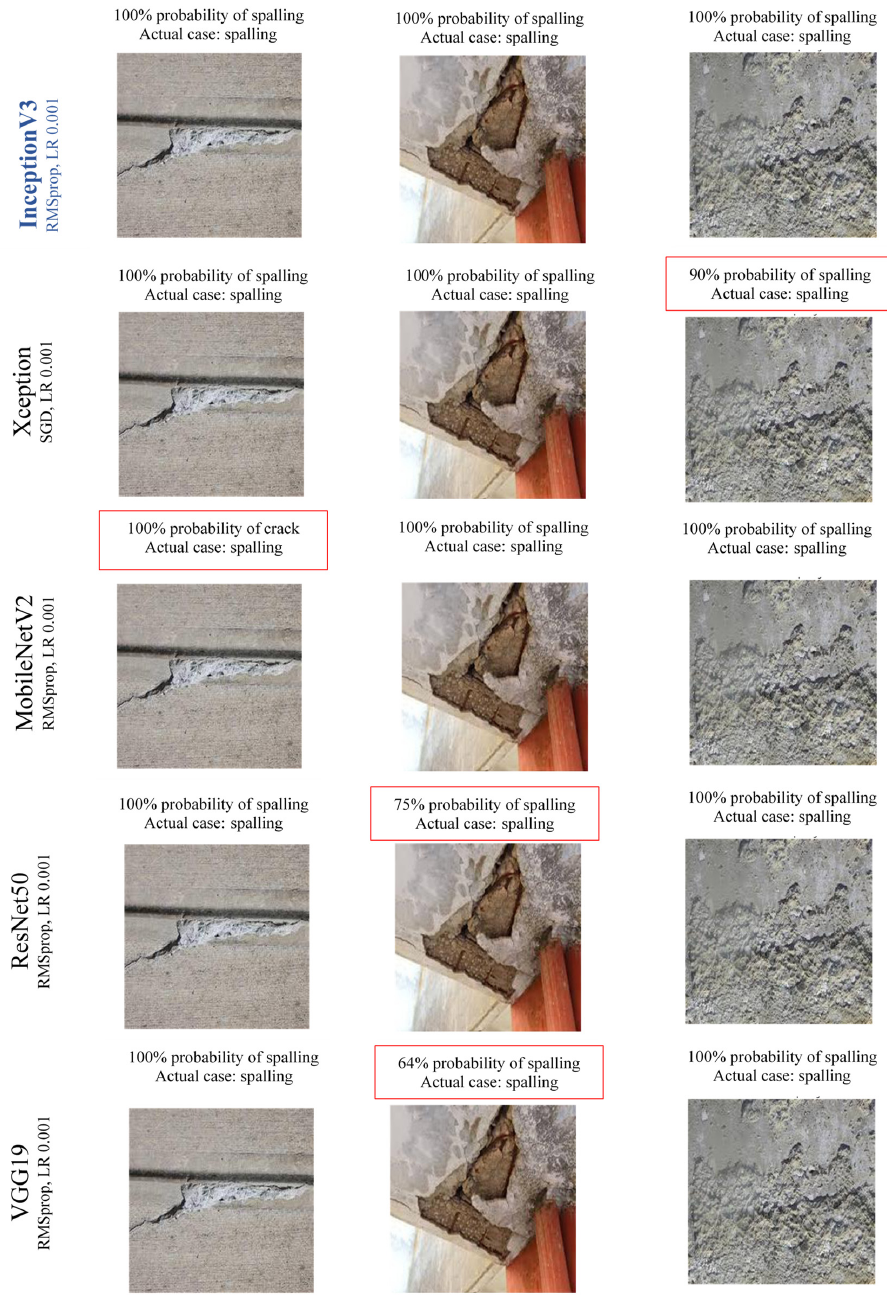
Figure 11. Sample images for spalling prediction using